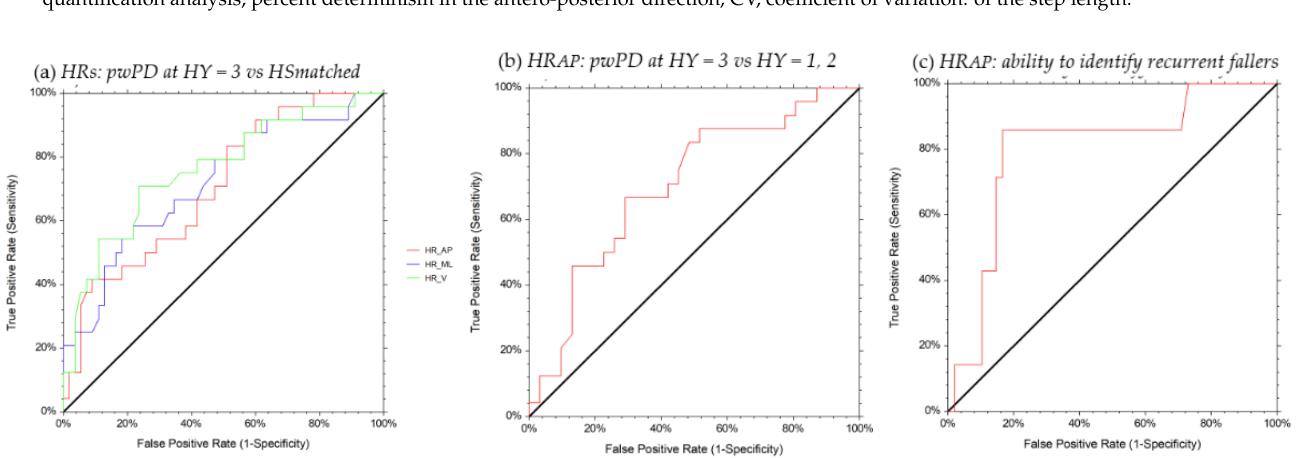
Figure 4. ROC curves of the CV ( a ) and RQAdetAP ( b ) in discriminating pwPD from HS matched. 3.3. Partial Correlation Analysis Results After removing the effects of gait speed and age, HR AP was negatively correlated with the history of falls (r = − 0.45, p = 0.004) and positively correlated with pelvic obliquity (r = 0.37, p = 0.024) and pelvic rotation (r = 0.31, p = 0.040). RQA detAP was negatively correlated with gait cadence (r = − 0.35, p = 0.031) and positively correlated with stride time (r = 0.36,